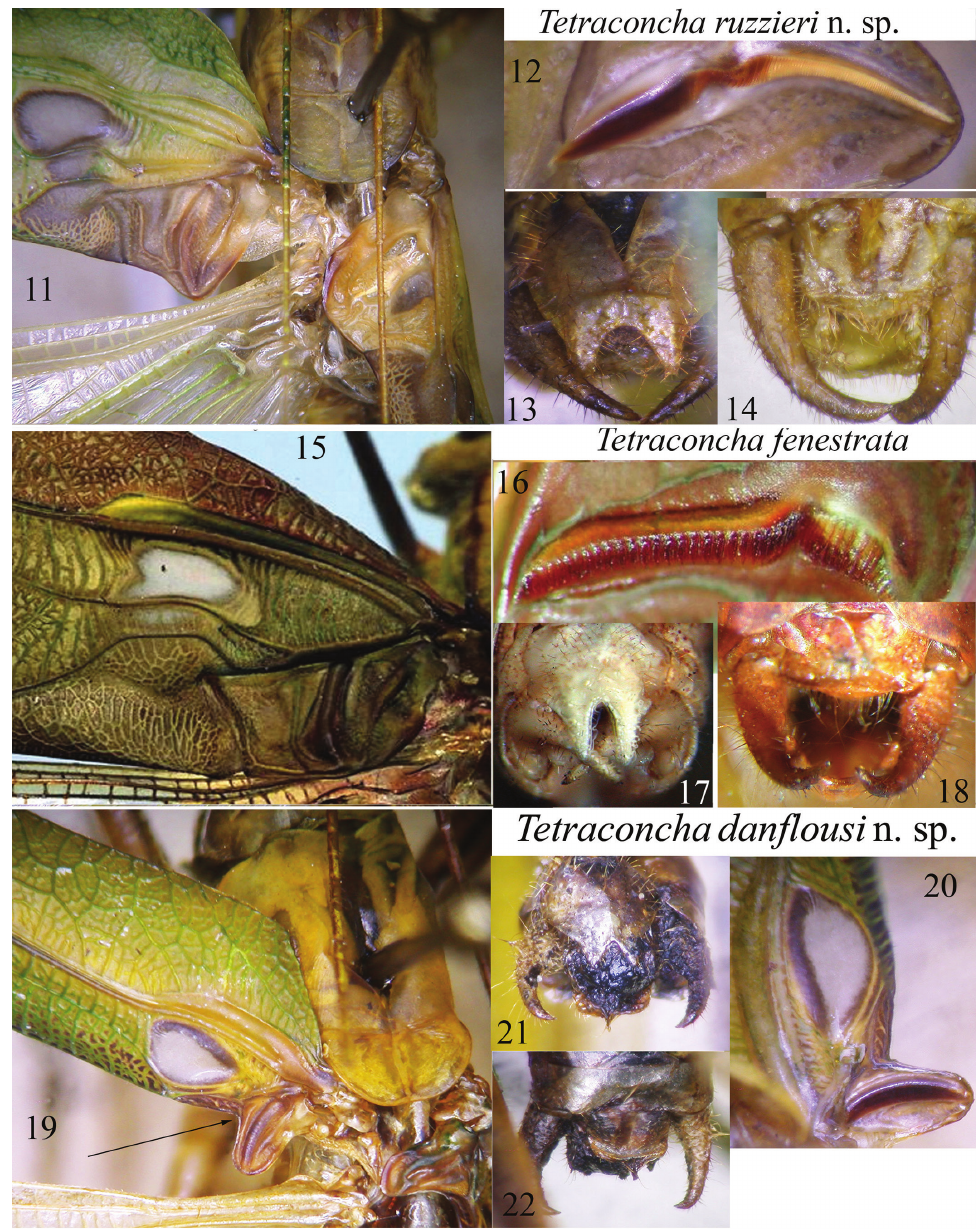
Figs 11–22. Tetraconcha ruzzieri sp. n. paratype male (Ivory Coast, Taï Nat. Park): 11. Stridulatory area; 12. Stridulatory file below the left tegmen; 13. Subgenital plate in ventral view; 14. Cerci in dorsal view. Tetraconcha fenestrata holotype male (Cameroon): 15. Stridulatory area of the left tegmen; 16. Stridulatory file below the left tegmen. Tetraconcha fenestrata male (Cameroon, Mukonje Farm): 17. Subgeni- tal plate in ventral view; 18. Cerci in dorsal view. Tetraconcha danflousi sp. n. holotype male (Ivory Coast, Taï Nat. Park): 19. Stridula- tory area; 20. Stridulatory file below the left tegmen and “window” of the left tegmen; 21. Subgenital plate and cerci in ventral view; 22. Cerci in dorsal view. Figs 15 and 16 after Orthoptera Species File.